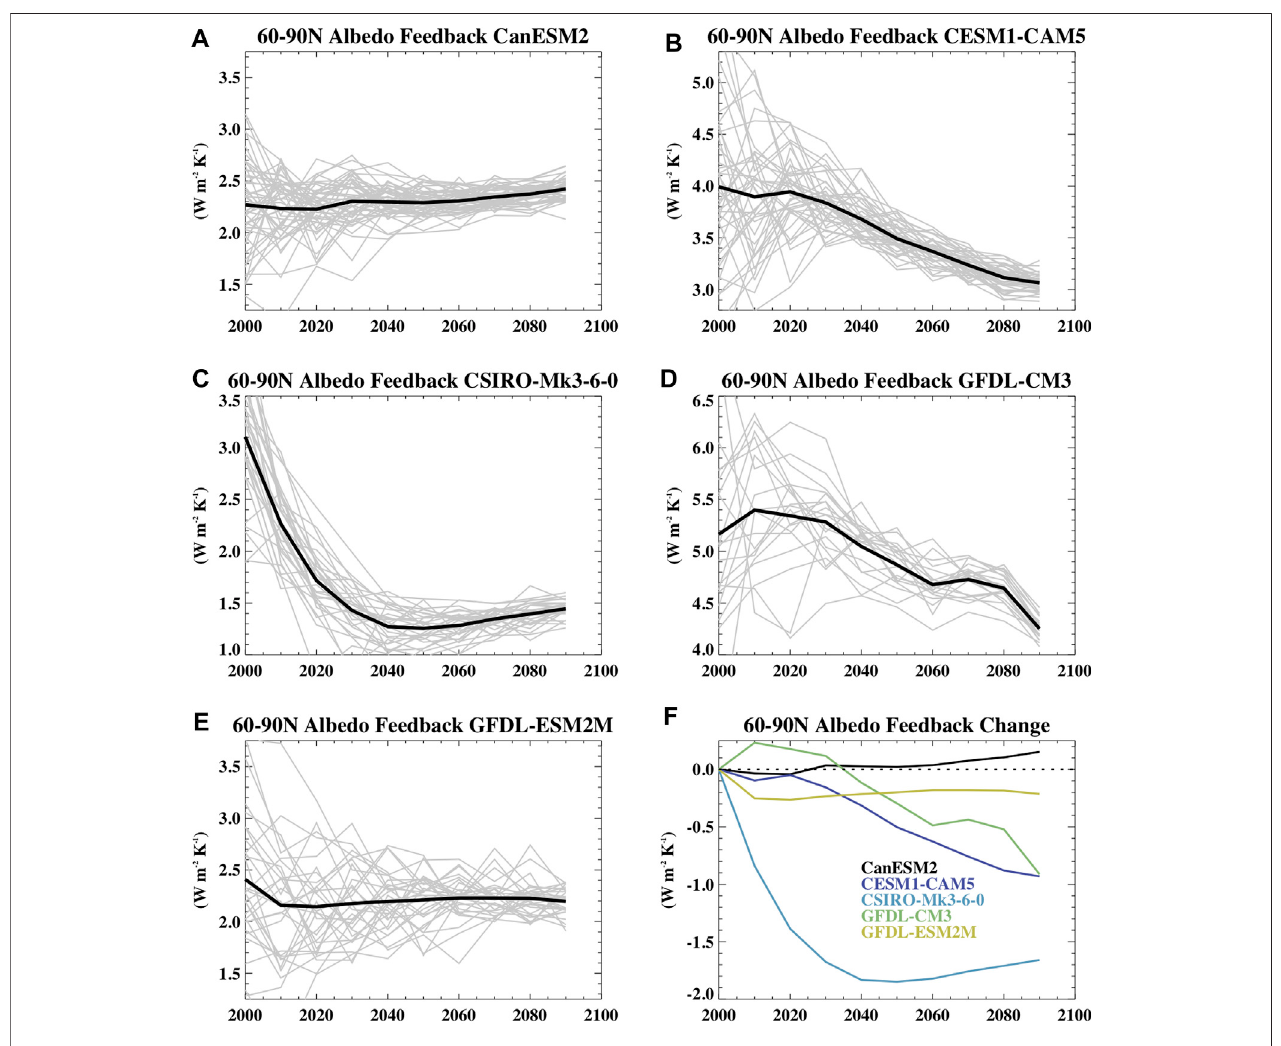
FIGURE 9 | Same as Figure 8 but for the 60 – 90N